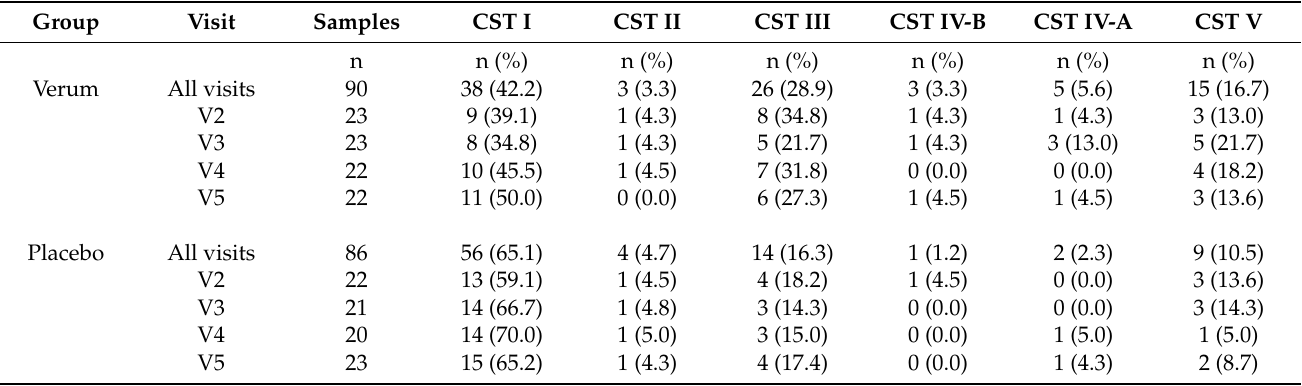
Figure 3. Relative abundance of species in the vaginal microbiota for verum and placebo participants consuming 10 10 CFU Lactobacillus acidophilus La-14 and Lacticaseibacillus rhamnosus HN001, or mal- intervention; Visit 4, after two weeks of intervention; Visit 5, after a one-week follow-up. Table 8. Community state type (CST) distribution of sequenced samples per group and visit. V, visit; V2, baseline visit; V3, after one week of intervention; V4, after two weeks of intervention; V5, after a one-week follow-up.